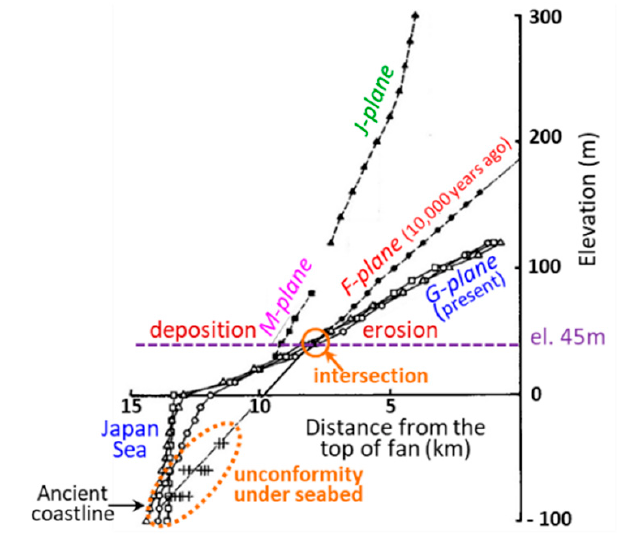
Figure 2. Radial section profiles of alluvial fans.